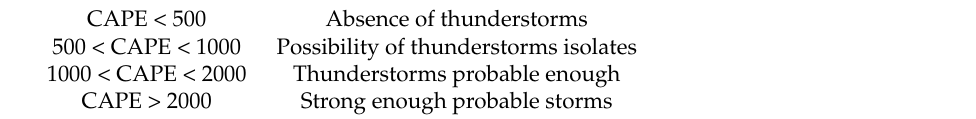
Table 1. Numerical values of CAPE associated to the formation of thunderstorms.